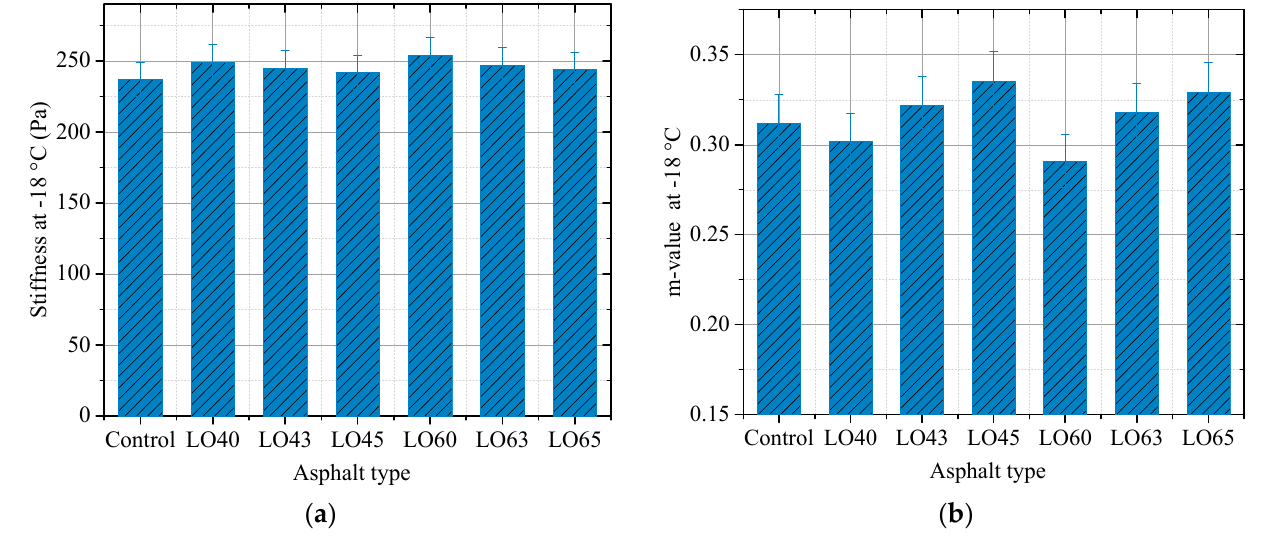
Figure 6. The BBR results at − 18 °C. ( a ) Stiffness; ( b ) m-value.